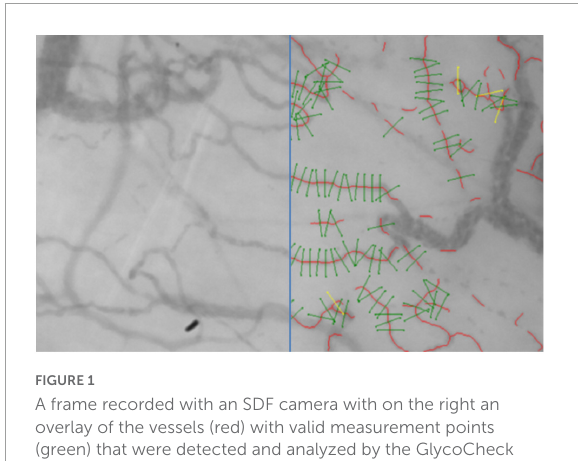
FIGURE1 A frame recorded with an SDF camera with on the right an overlay of the vessels (red) with valid measurement points (green) that were detected and analyzed by the GlycoCheck software.